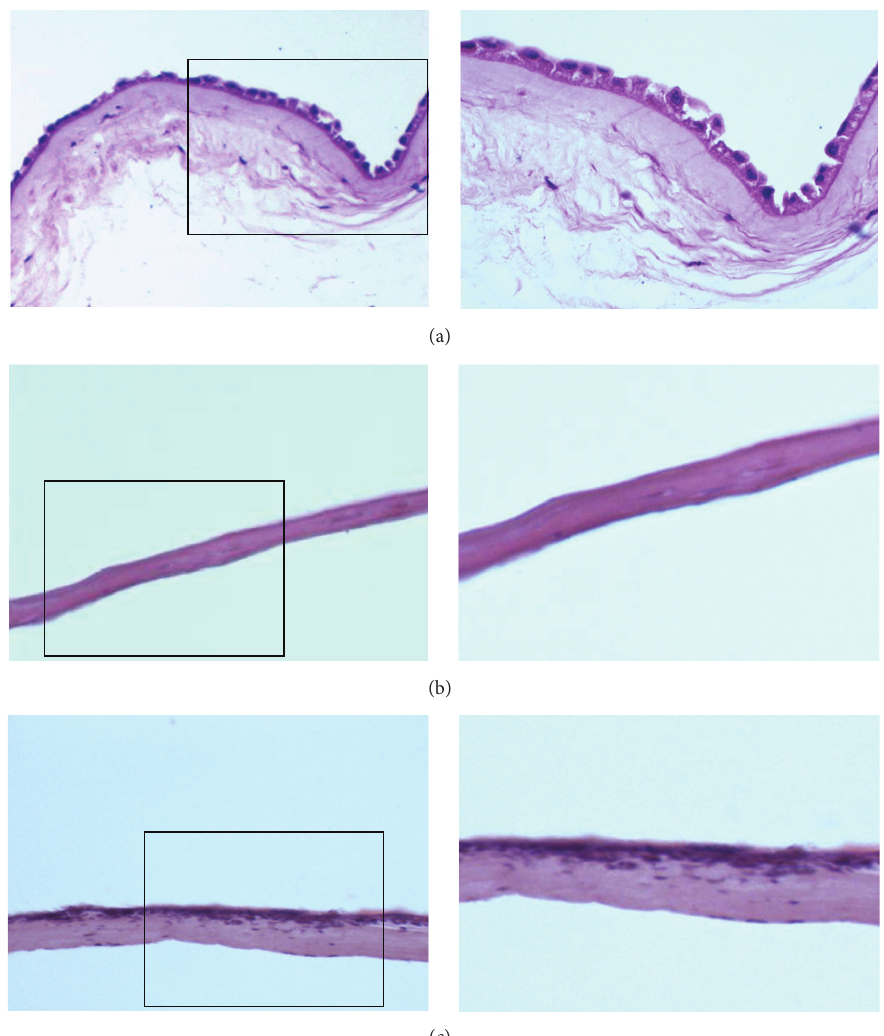
Figure 2: Morphology of hAM (a), AAM (b), and AAM loaded with ADMSCs (c). The right is the magnification of the left. HE staining showed that the epidermal layer of the intact AM was complete and continuous with the nucleus clearly seen and disappeared in AAM. After loading ADMSCs onto AAM, cells covered the surface of AAM and fused into patches.